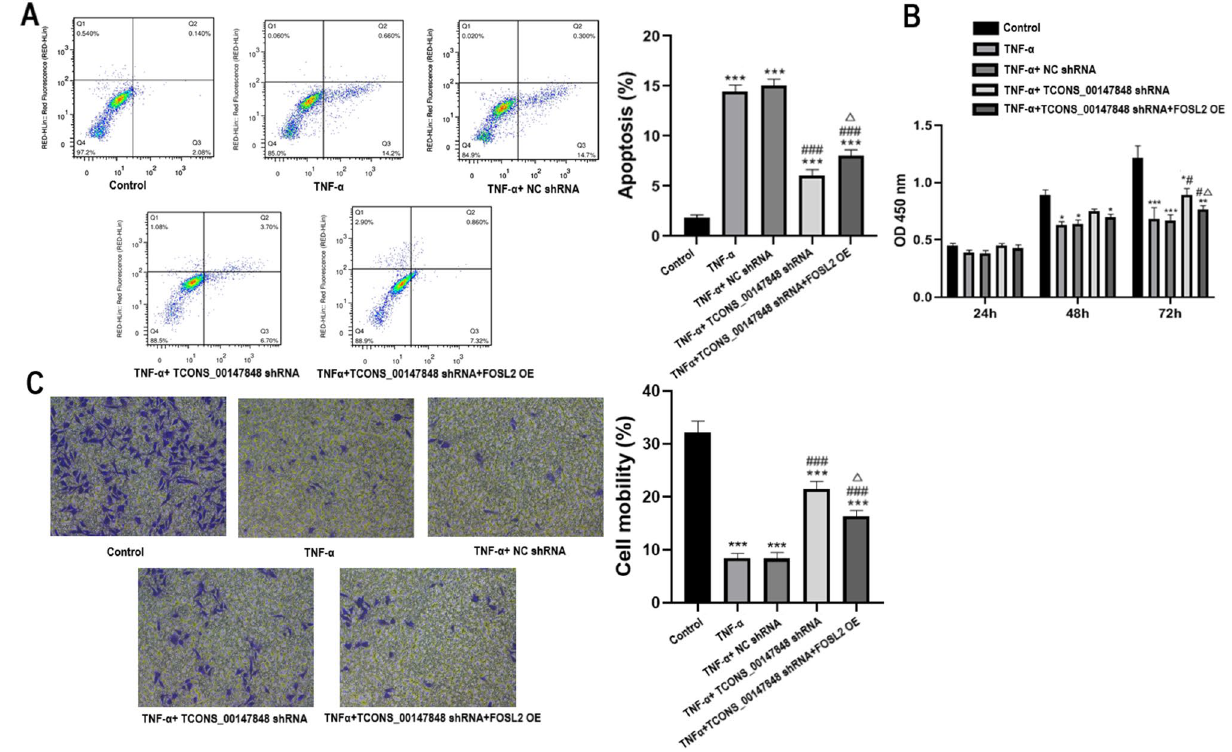
Figure 6. TCONS_00147848 and FOSL2 regulated apoptosis, proliferation and migration of nasal mucosa cells of mice treated with TNF- α. ( A ) Apoptosis of nasal mucosa cells of mice detected by Annexin V/PI (Software version: BD ACCURI C6 software; URL: https:// www. Accur iCyto meters. com). ( B ) Proliferation of nasal mucosa cells of mice detected by CCK-8. ( C ) Migration of nasal mucosa cells of mice detected by transwell. * P < 0.05 vs. Control group, ** P < 0.01 vs. Control group, *** P < 0.001 vs. Control group, # P < 0.05 vs. TNF-α group, ### P < 0.001 vs. TNF-α group, △ P < 0.05 vs. TNF-α + TCONS_00147848 shRNA group (Software version: SPSS 23.0; URL: https:// www. ibm. com/ legal/ copyt rade. are shown in Fig. 6B,C. Compared with the control group, the proliferation and migration of cells in TNF-α group, TNF-α + NC shRNA group, TNF-α + TCONS_00147848 shRNA group and TNF-α + TCONS_00147848 shRNA + FOSL2 OE group significantly decreased ( P < 0.05). Compared with the TNF-α group, the proliferation and migration of TNF-α + TCONS_00147848 shRNA group and TNF-α + TCONS_00147848 shRNA + FOSL2 OE group significantly increased ( P < 0.05). Compared with the TNF-α + TCONS_00147848 shRNA group, the proliferation and migration of TNF-α + TCONS_00147848 shRNA + FOSL2 OE group significantly decreased ( P < 0.05). Effects of TCONS_00147848 and FOSL2 on expression of inflammatory factors and TCONS_00147848 in nasal mucosa cells of mice treated with TNF‑α. Compared with the control group, the expression levels of IgE, IL-4, IL-5, IL-9, IL-10, IL-25, IL-33 IFN-γ, TNF-α, TSLP and TCONS_00147848 were significantly up-regulated in TNF-α group, TNF-α + NC shRNA group, TNF-α + TCONS_00147848 shRNA group and TNF-α + TCONS_00147848 shRNA + FOSL2 group ( P < 0.05). Compared with the TNF-α group, the expression levels of IgE, IL-4, IL-5, IL-9, IL-10, IL-25, IL-33 IFN-γ, TNF-α, TSLP and TCONS_00147848 in TNF-α + TCONS_00147848 shRNA group and TNF-α + TCONS_00147848 shRNA + FOSL2 OE group sig- nificantly decreased ( P < 0.05). However, compared with the TNF-α + TCONS_00147848 shRNA group, the expression levels of IgE, IL-4, IL-5, IL-9, IL-10, IL-25, IL-33 IFN-γ, TNF-α, TSLP and TCONS_00147848 in TNF-α + TCONS_00147848 shRNA + FOSL2 OE group significantly increased ( P < 0.05) (Fig. 7A,B). Effects of TCONS_00147848 and FOSL2 on expression of FOSL2, JAK‑2, STAT3, P‑STAT3, BAX, and BCL‑2 in nasal mucosa cells of mice treated with TNF‑α. Compared with the control group, the expressions of FOSL2, JAK-2, P-STAT3, and BAX were significantly up-regulated in TNF-α group, TNF-α + NC shRNA group, TCONS_00147848 shRNA group and TNF-α + TCONS_00147848 shRNA + FOSL2 OE group ( P < 0.05). Compared with the TNF-α group, the expressions of FOSL2, JAK-2, P-STAT3, and BAX in TNF-α + TCONS_00147848 shRNA group and TNF-α + TCONS_00147848 shRNA + FOSL2 OE group signifi- cantly decreased ( P < 0.05). However, BCL-2 expression trend was opposite to that of FOSL2, JAK-2, P-STAT3, and BAX, without significant difference in STAT3 expression among all groups (Fig. 8).